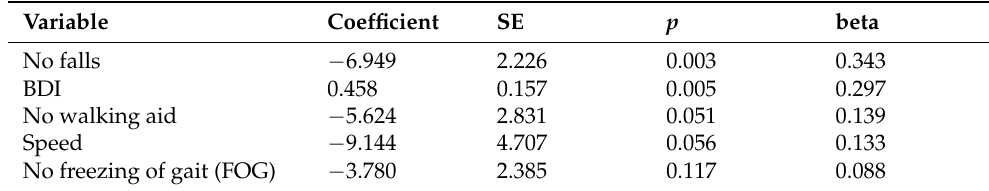
Table 4. Multiple linear